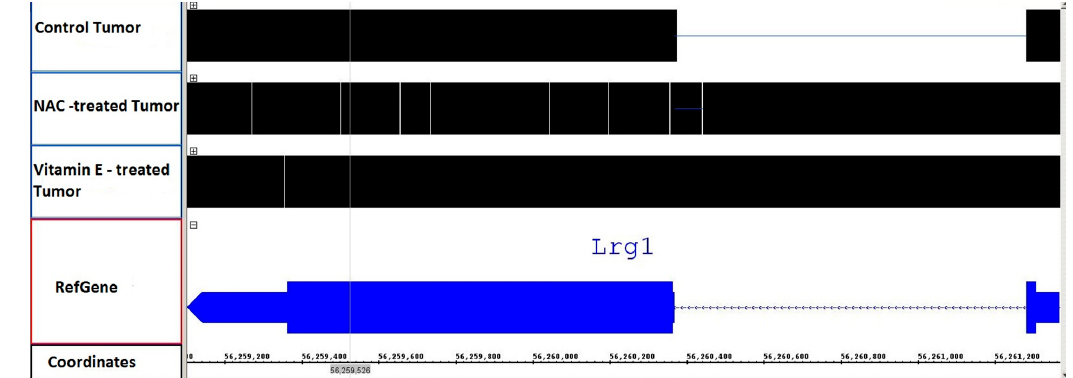
Figure 2. Illustration of genomic alignment of reads mapping to LRG1. For LRG1 gene, the exonic regions of the gene are shown as blue blocks and the intronic region as blue line (two exons and one intron). The regions with reads mapping to the gene are shown as black blocks. Both NAC and Vitamin E treated groups had reads mapping to the single intronic region compared to that of untreated control tumor tissue.